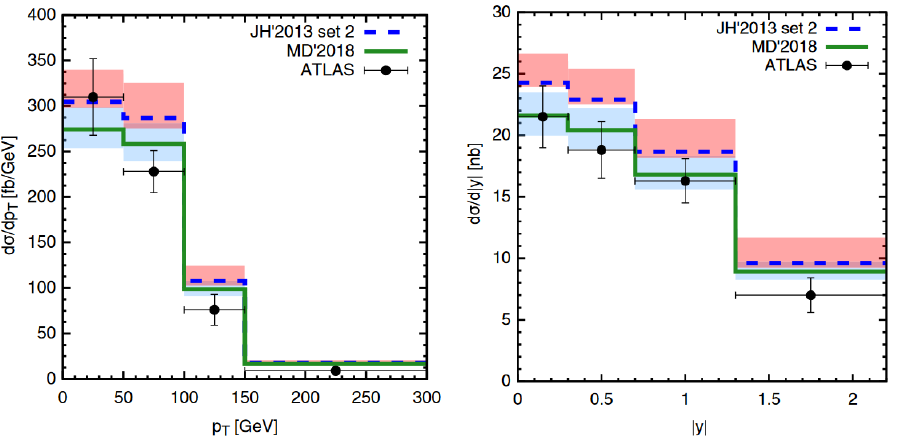
Figure 5. The differential cross sections of inclusive t-channel single antitop production at √ s = 8 TeV as functions of ¯ t quark transverse momentum and rapidity. Notation of the histograms is the same as in Fig. 1. The experimental data are from ATLAS [24]